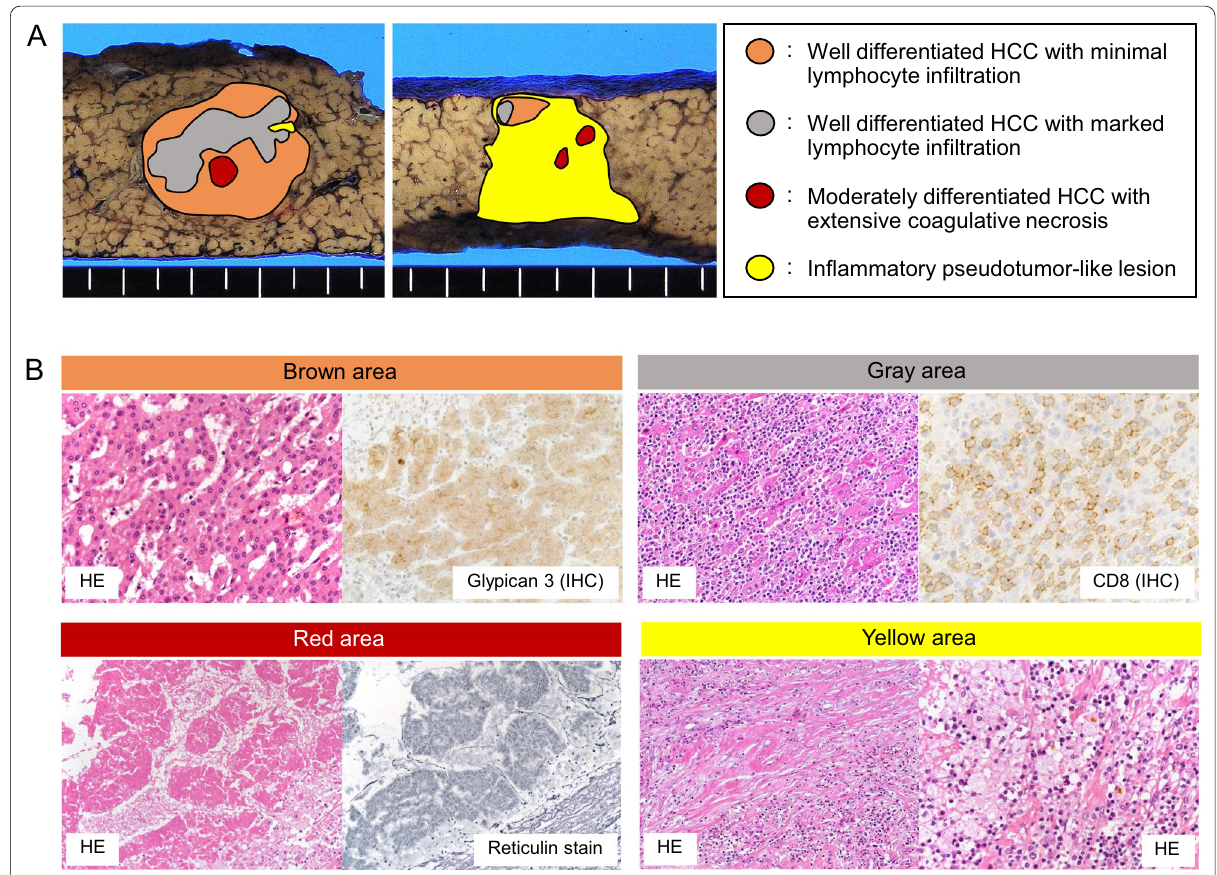
Fig. 5 Illustrative presentation and histology of the tumor. The areas colored brown, gray, red and yellow were superimposed on the cut surface images of Fig. 1c, d. a Representative histological images corresponding to each colored area are shown in b . IHC